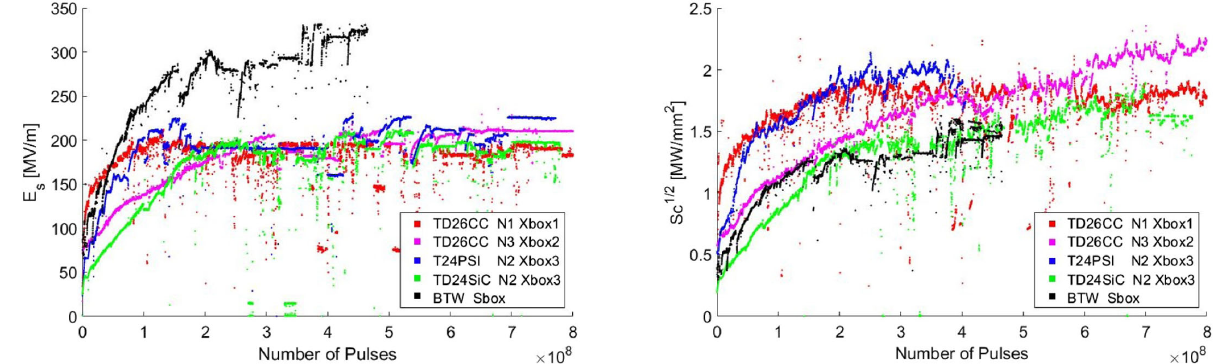
(left) and the peak modified Poynting vector S s